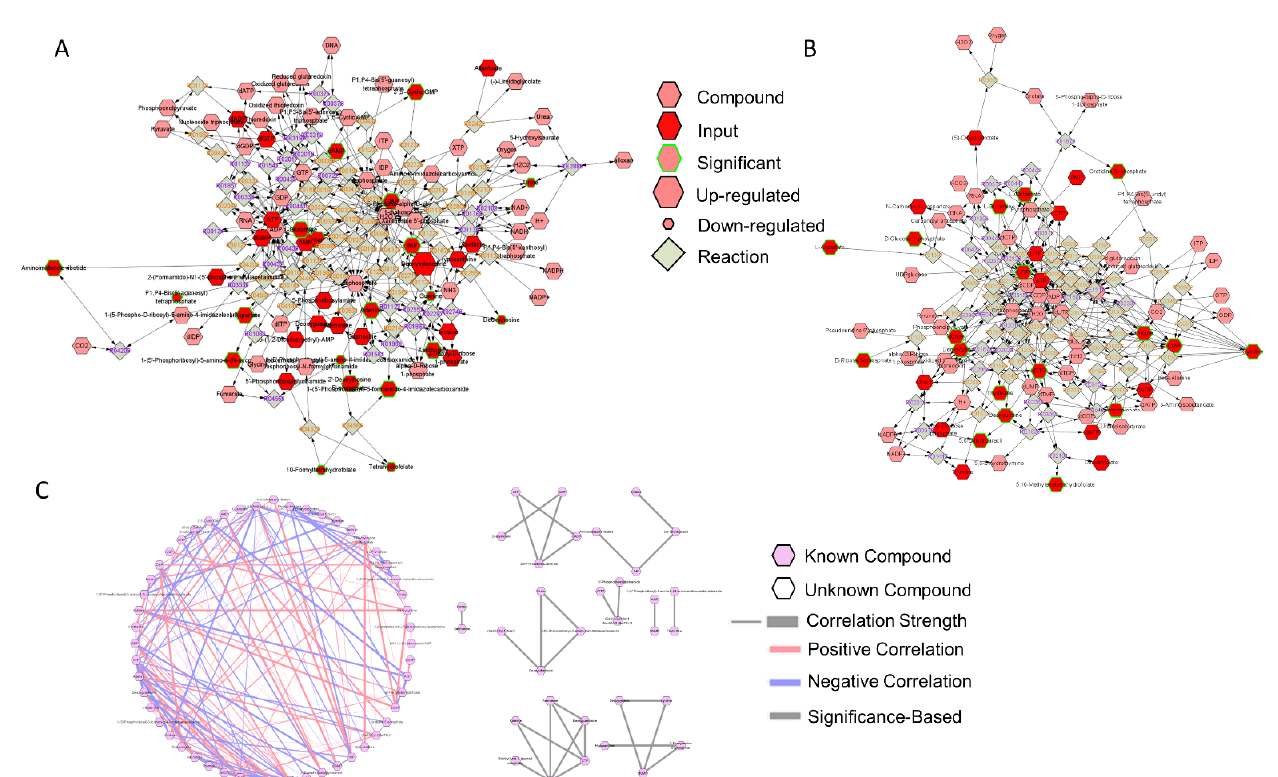
Figure 6. The network of purine and pyrimidine metabolisms. Subnetworks of the ( A ) purine and ( B ) pyrimidine metabolism pathways. Metabolites highlighted in green indicated statistically significant features. ( C ) Correlation of metabolites annotated in the purine and pyrimidine metabolism pathways. Connections in red and blue indicated positive and negative correlation between the two metabolites, respectively. Statistically significant correlations of metabolites were highlighted with grey. p < 0.05.